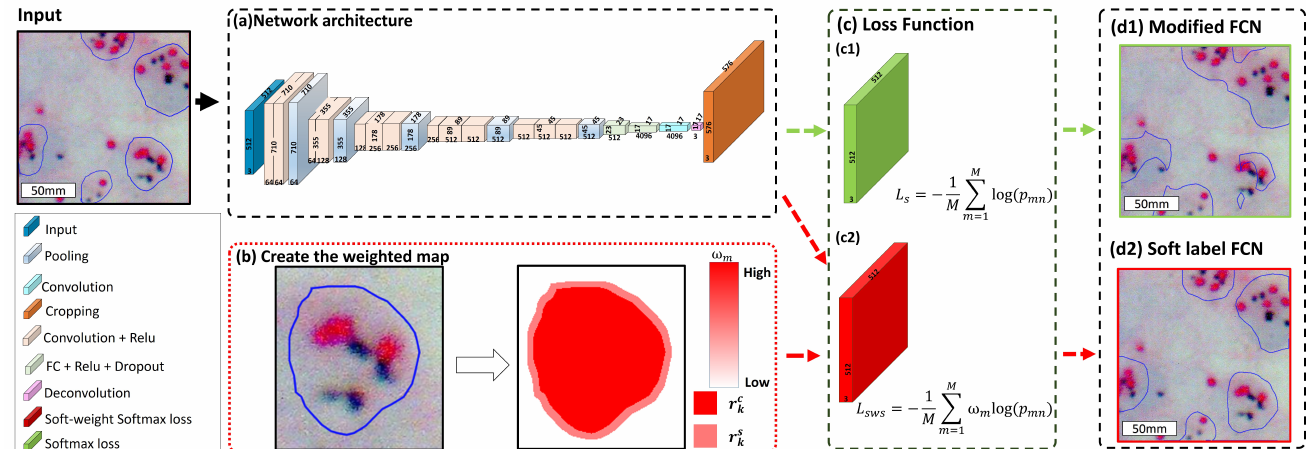
Figure 2. The main architecture of the soft-labeled FCN in DISH breast dataset 1. ( a ) the soft-labeled FCN network architecture; ( b ) create the weighted map and obtain the pixel weight ω m as the input for soft-weight softmax loss; ( c ) the loss function comparison; ( c1 ) is the original loss function in the modified FCN network; ( c2 ) is the soft-weight softmax loss in our proposed method; ( d1 ) is the output result of the modified FCN network; ( d2 ) is the output result of the soft-labeled FCN